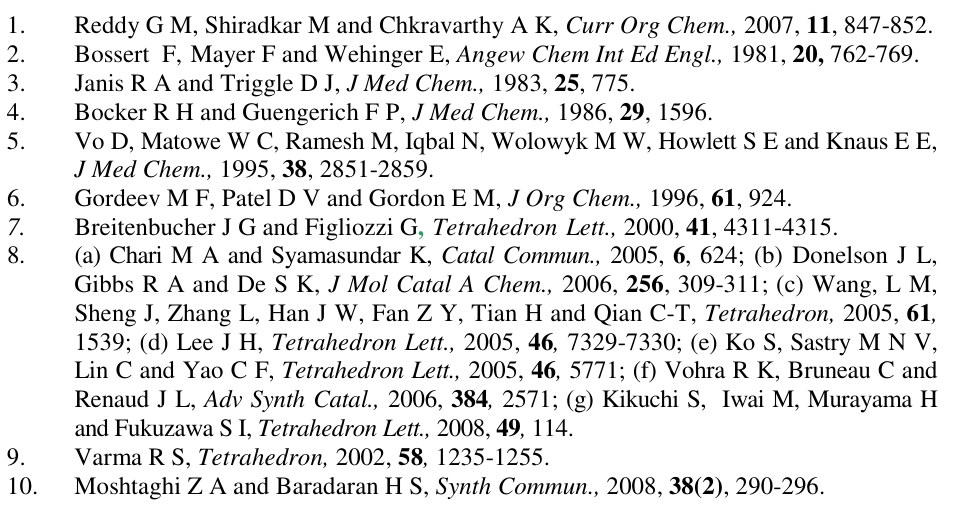
m.p, ˚c Yield b ,% Yield a , % Product Aldehyde